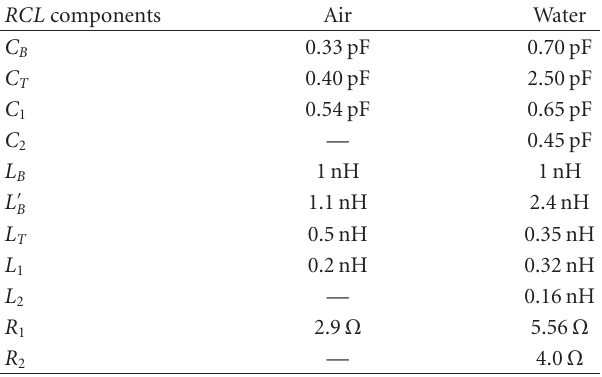
Table 1: RCL component values in (20) for air and water